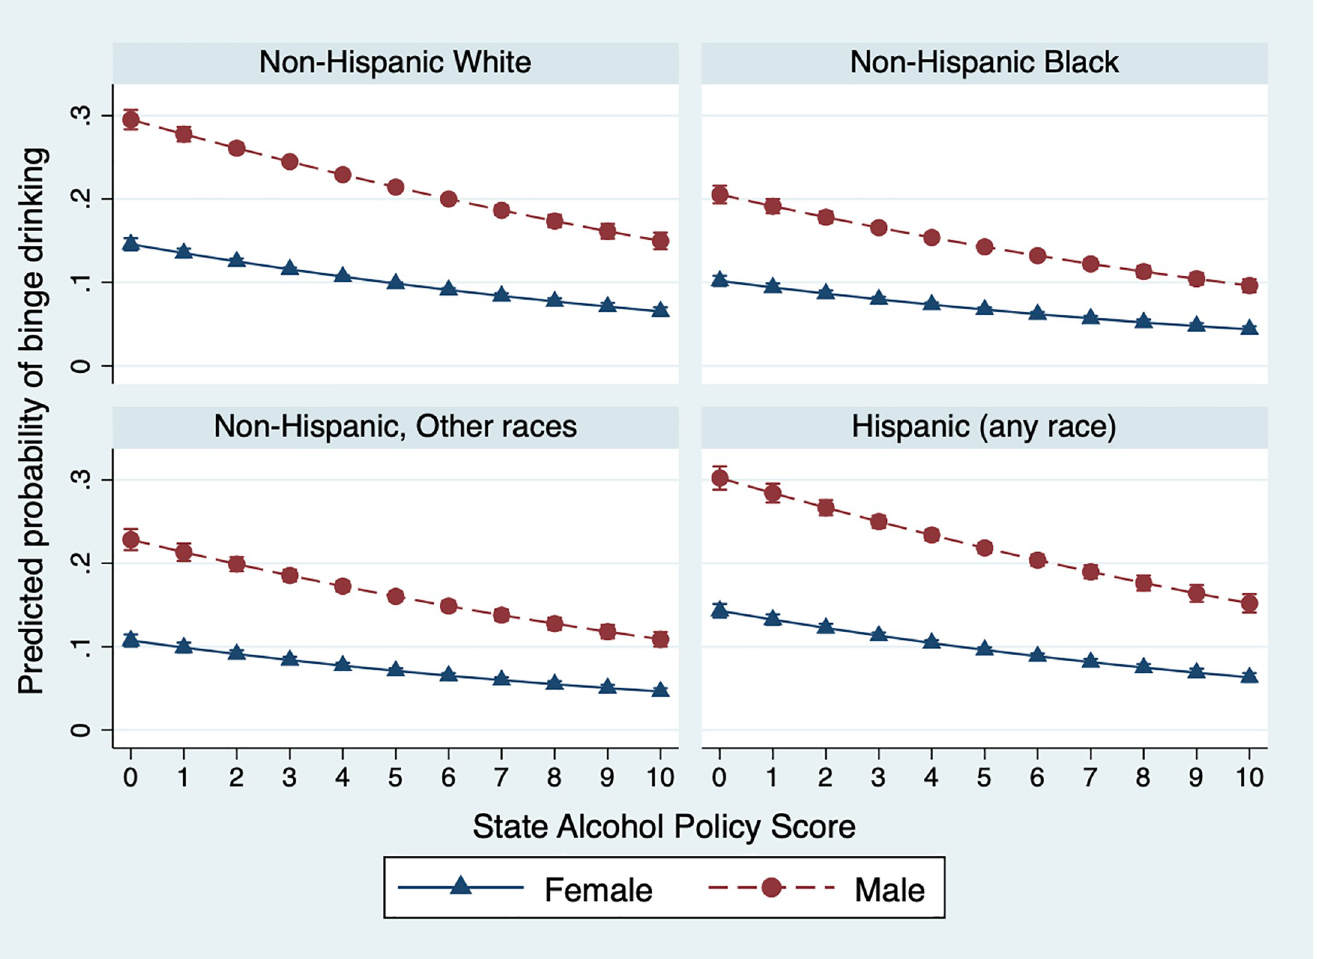
Fig 2. Predicted probability of binge drinking, by SAPS score, race/ethnicity, and gender, 2005–2010. Data from BRFSS and other sources. Predicted probability from full GLM regression model controlling for individual-level factors (sex, educational attainment, age, race/ethnicity, marital status, household income, employment status) state-level factors (percent poverty, police per 1000 persons, population that is white, percent of population 21 and over, percent female, population density, geographic region), and year, adjustment for survey design, and including individual